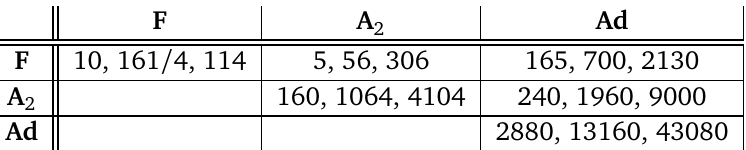
) d abcd ( R ) for SO ( 7,8,9,10,11 ) respec- 1 2 ( F ) = 1. For the “physicist” normalization l ( F ) = 1 / 2 mul- 2 2 S